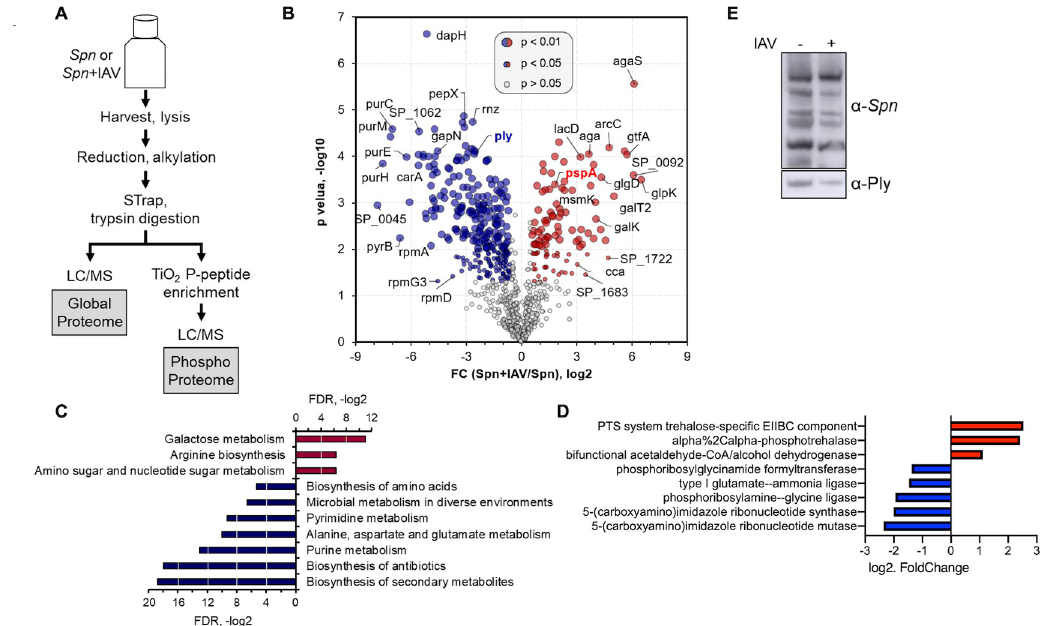
Fig 2. Global proteomic change of Spn in the presence of Influenza virus. ( A ) Workflow for global and phosphoproteome profiling of Spn . ( B ) Spn proteins identified from the global proteome analysis shown in a volcano plot. Red and blue are proteins significantly up- or down-regulated by 1.5-fold when co-incubated with IAV (Student’s t-test, p < 0.05 or p < 0.01 for sizes indicated). KEGG enrichment analysis of significant ( C ) proteins and ( D ) transcripts. ( E ) Western blot of Spn lysate grown in presence or absence of IAV, probed with a polyclonal anti- Spn or anti-Pneumolysin antibody.